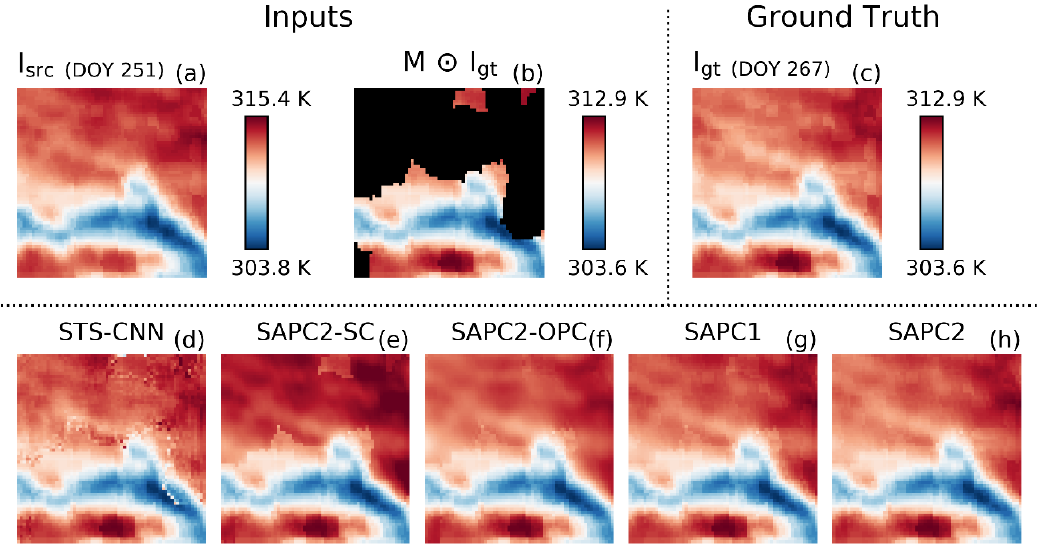
Figure 10. The same as Figure 9 but for Case 2. The acquisition DOYs for source and target inputs are 251 and 267, respectively. The masked fraction of the target image ( b ) is 0.531. The correlation coefficient between source ( a ) and ground truth ( c ) images is 0.975.